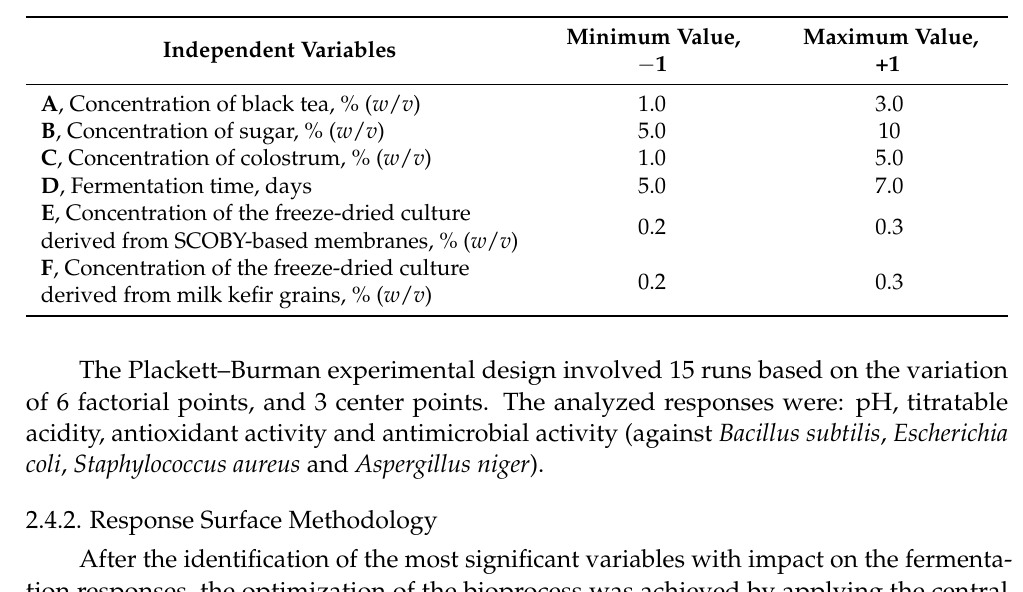
Minimum Value, Maximum Value, − 1 +1 1.0 3.0